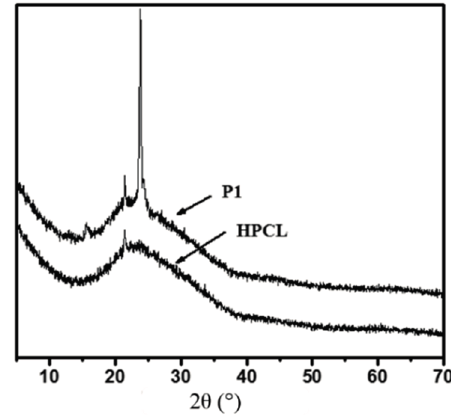
Figure 8. WAXD (wide-angle X-ray diffraction) spectra of the linear poly( ε -caprolactone) (P1, M n GPC = 7400 g/mol, M w / M n = 1.15) and hyperbranched poly( ε -caprolactone) (HPCL, M n GPC = 25,500 g/mol, M w / M n = 2.38) at room